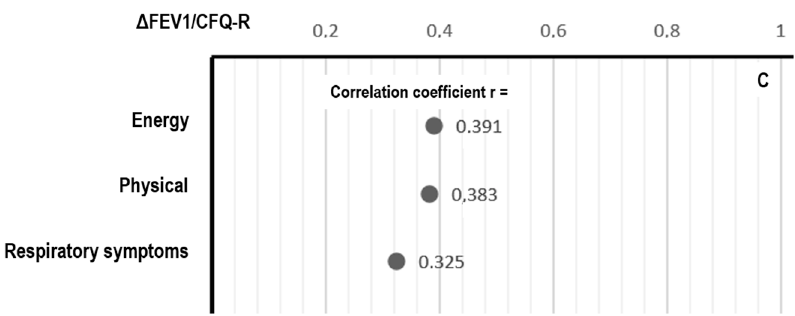
Figure 8. Correlation analysis of Δ FEV1/CFQ-R (days 0–28).